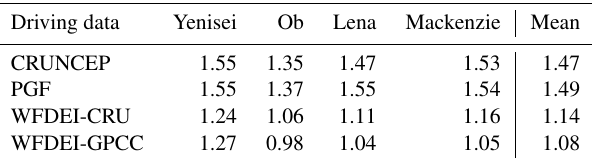
Table 2. Precipitation scale factors, calculated as the ratio of GRACE-derived to data set precipitation, using all years of over- lap between each driving data set and